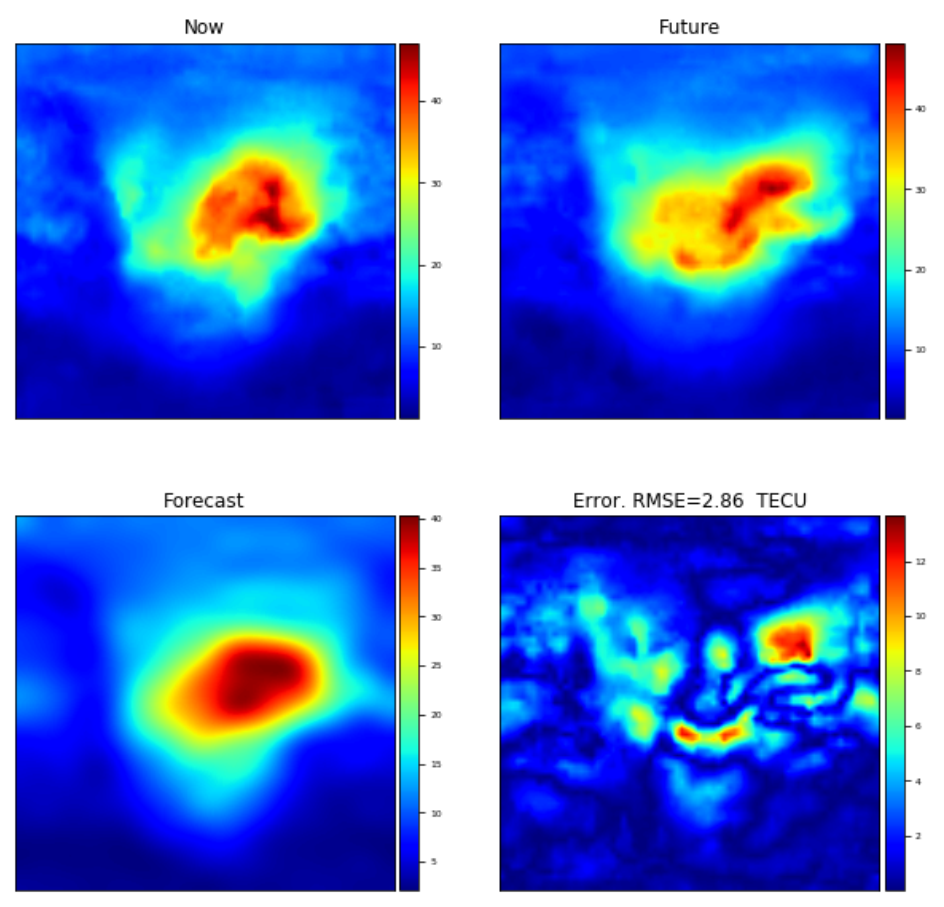
Figure 2. Forecasting by means of the DCT method at a horizon of 3 h. Time stamp, 2016-02-21 13:15:00 (Year-Month-Day Hour:Minute:Second): current map ( upper left ); future map ( upper right ); forecast ( lower left ); and forecast error ( lower right